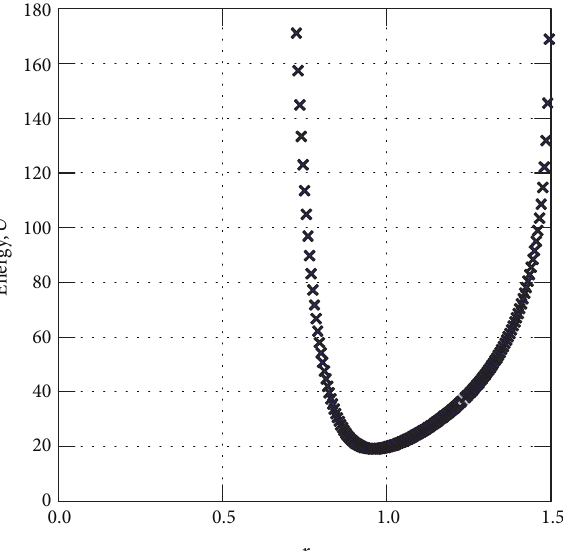
Figure 5: Total potential energy between two beads.